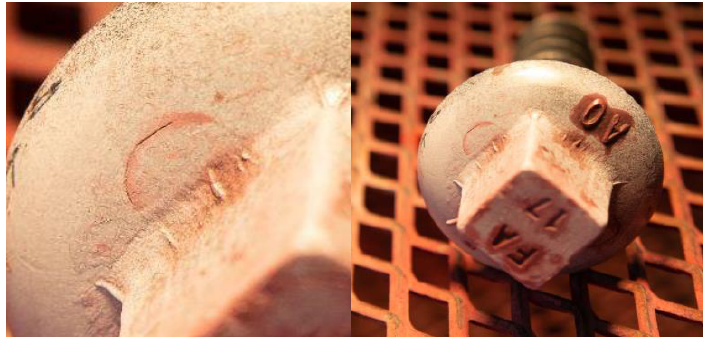
Figure 8. Folds exposed by penetrating inks on the cap of the screw.